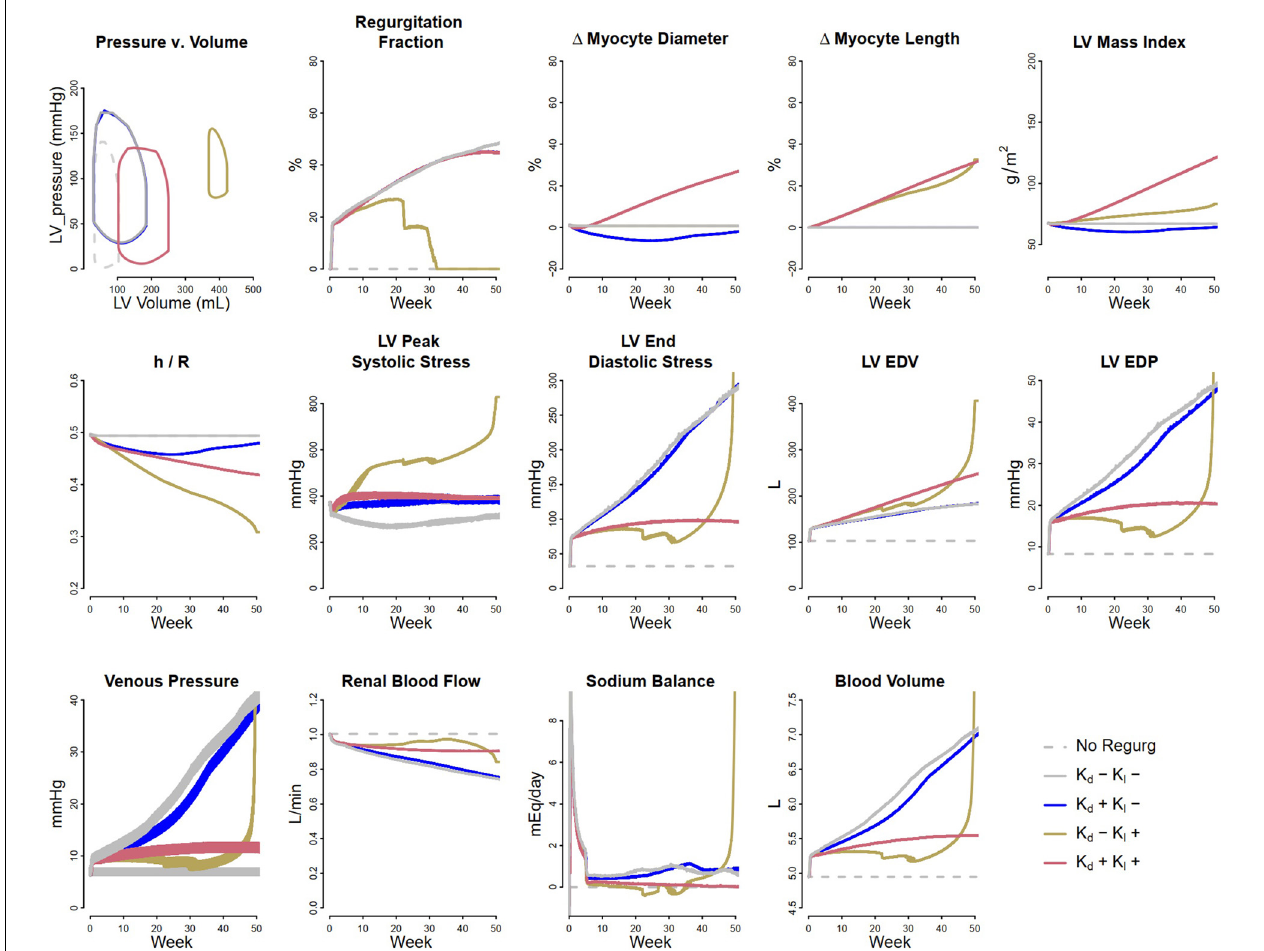
FIGURE 4 | Simulated response to volume overload due to mitral regurgitation under different remodeling assumptions. Gray dashed, baseline; Gray solid, no remodeling; Blue, only myocyte diameter allowed to change (K d0 > 0, K l0 = 0); Brown, only myocyte length allowed to change (K d0 = 0, K l0 > 0); Red, both myocyte diameter and myocyte length allowed to change (K d0 and K l0 >